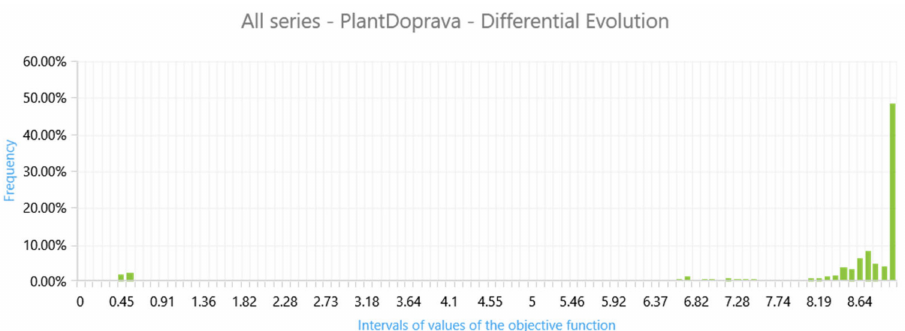
Figure 19. The percentage of the frequency of the objective function values of solution candidates generated by the differential